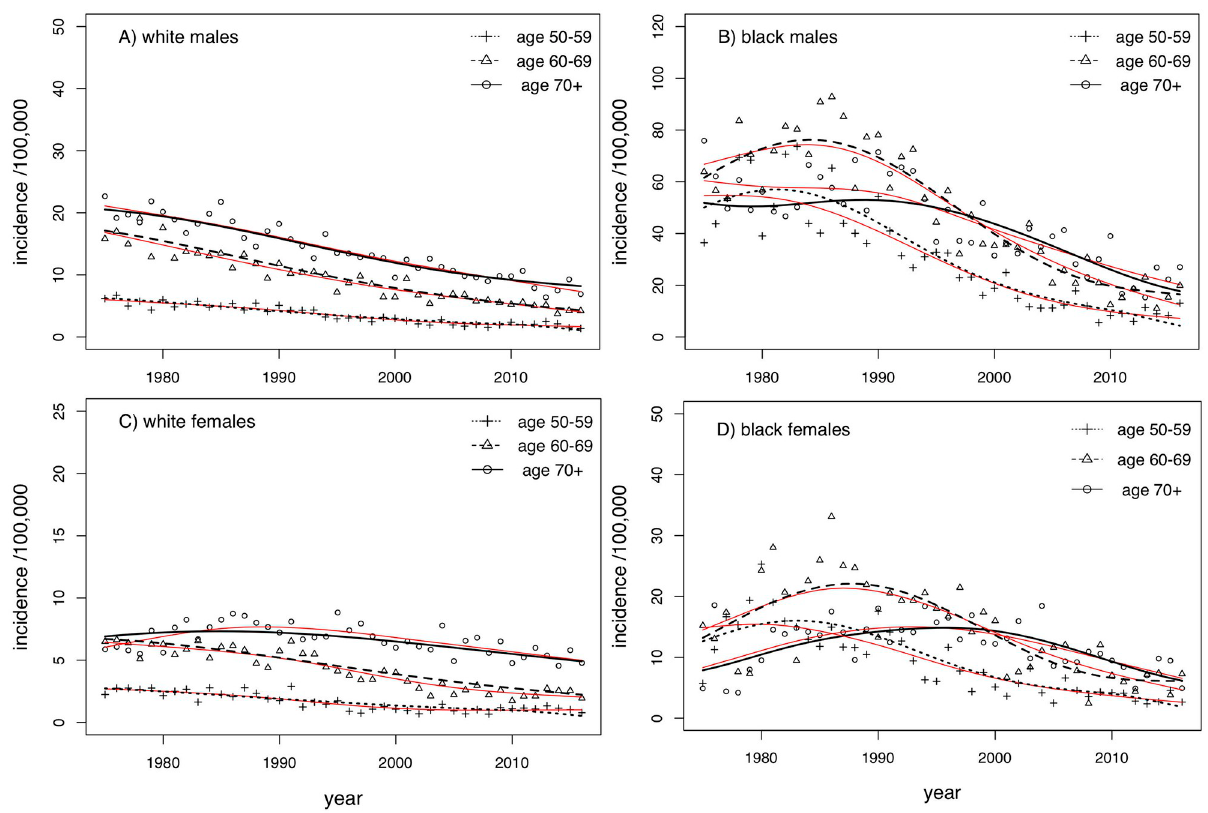
Fig 4. ESCC incidence (data, black shapes; model fits, black lines) by sex, race and age group as indicated from 1975-2016. For comparison, non- parametric fits using 4 th -order smoothing splines are shown in red.